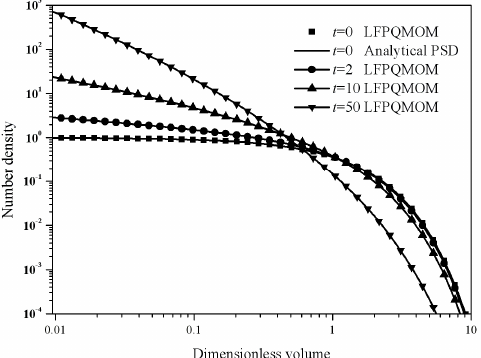
Figure 14. Particle size distributions at 0, 2, 10, and 50 s for the pure breakage process with constant kernel, exponential initial PSD, and uniform daughter distribution (square: numerical PSD at 0 s; line: analytical PSD at 0 s; circle line: numerical PSD at 2 s; up triangle line: numerical PSD at 10 s; down triangle line: numerical PSD at 50 s).